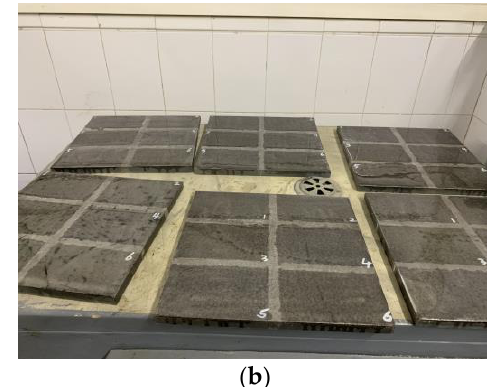
Figure 3. Steel plate area division: ( a ) Division of steel plates; ( b ) Coating different combinations of epoxy resin in different regions.